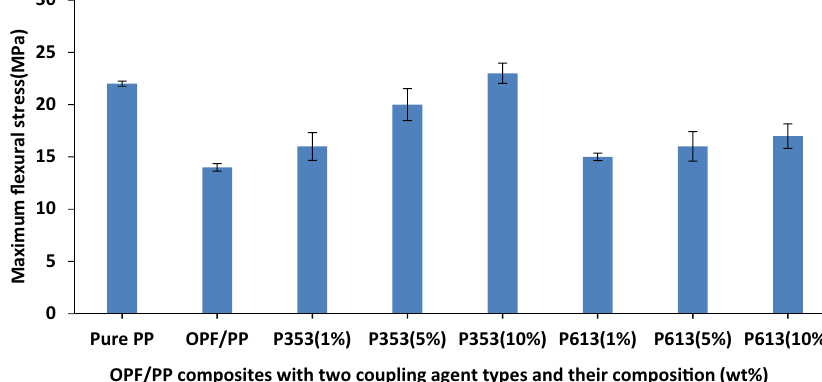
Figure 7: Maximum fl exural stress of the pure PP, uncoupled, and coupled 20% OPF/PP polymer composite with two coupling agent types of di ff erent weight